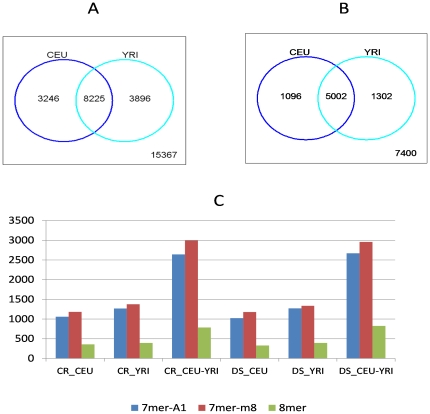
The summary of the predicted SNP-involved canonical miRNA target sites.
A: Venn diagram comparing the distribution of the predicted SNP-involved miRNA target sites between CEU and YRI populations. B: Venn diagram comparing the distribution of genes, each of which contains at least one SNP-involved miRNA target sites, between CEU and YRI populations. C: The distribution of the predicted SNP-involved miRNA target sites with respect to population (CEU and YRI) and site mutation type (DS: disrupted sites and CR: created sites).